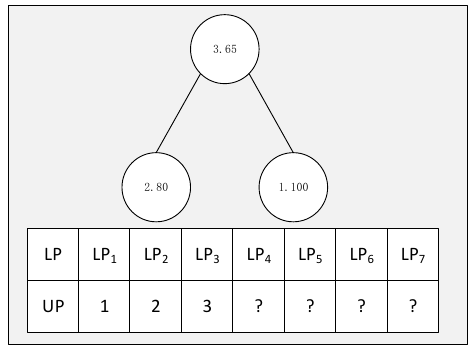
Figure 5. Initialize min-heap.